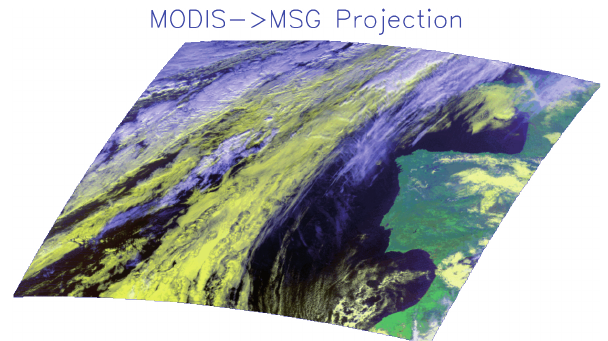
Fig. 2. MODIS false colour composite in MSG/SEVIRI projection. For 11 January 2009, 12:00UTC, west of